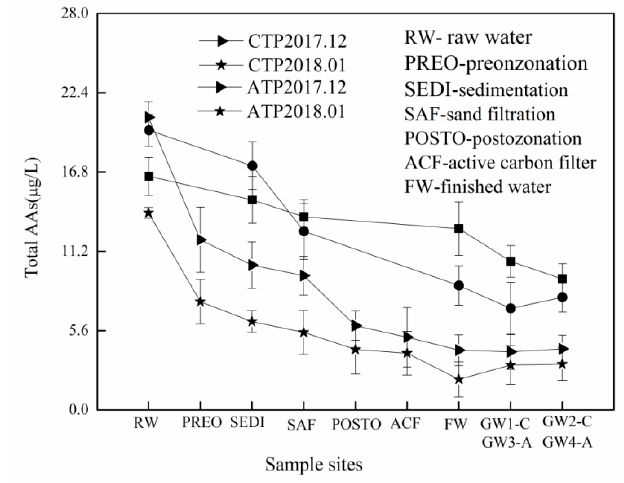
Figure 4. The variation of total FAAs in conventional and advanced treatment processes. (CTP is